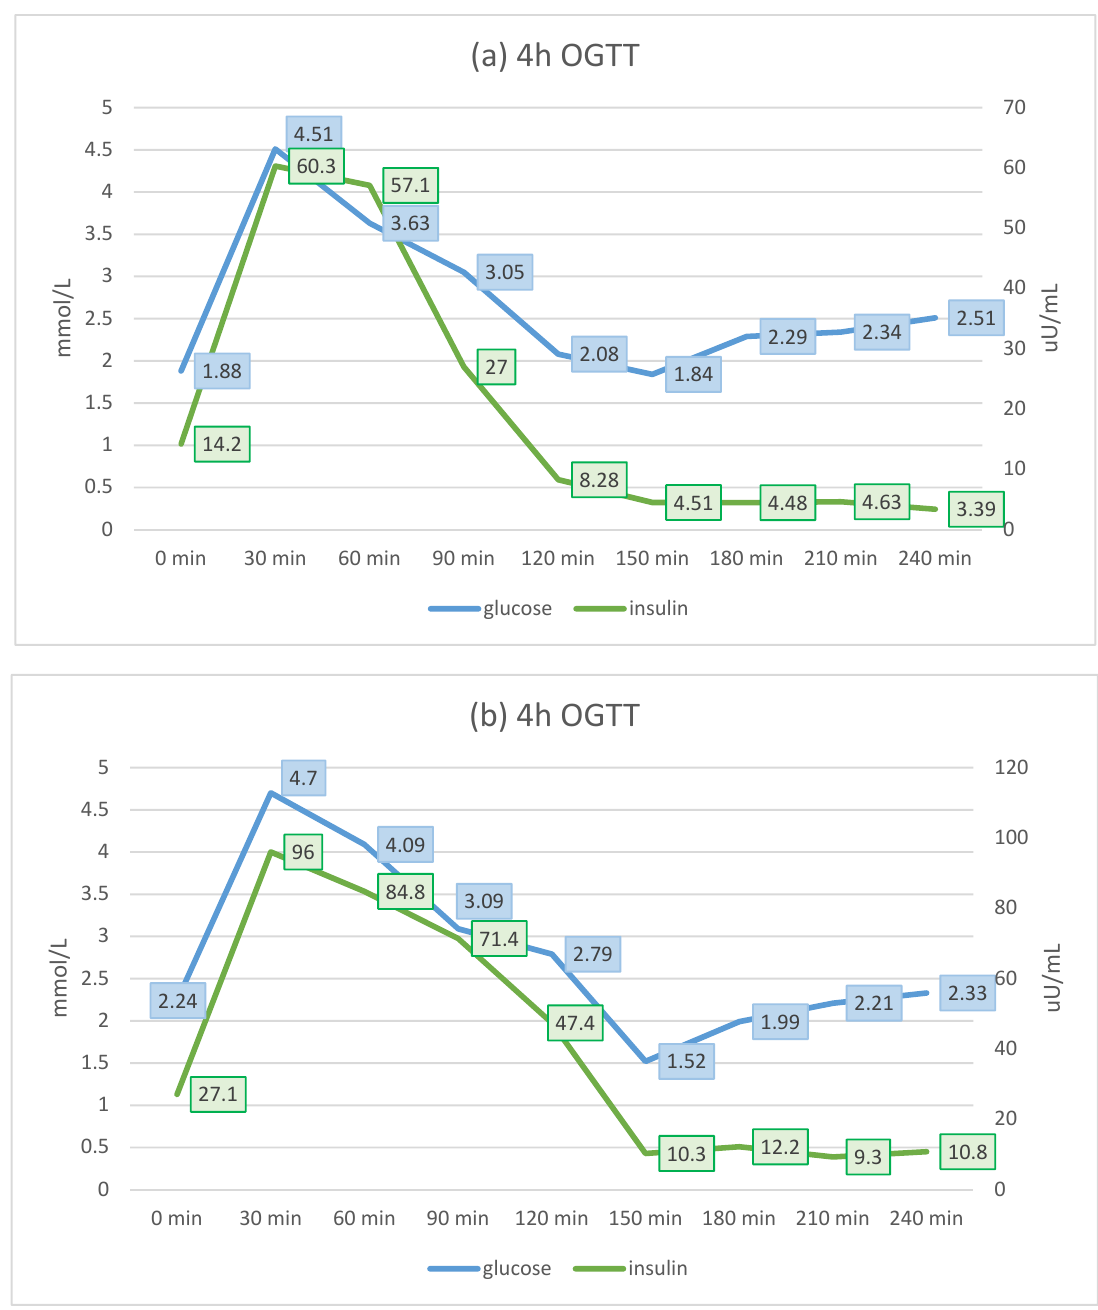
Figure 3. Blood glucose (blue) and insulin (green) levels during four-hour OGTT in index patient I.1 ( a ) and his son II.1 ( b ). OGTT: oral glucose tolerance test.